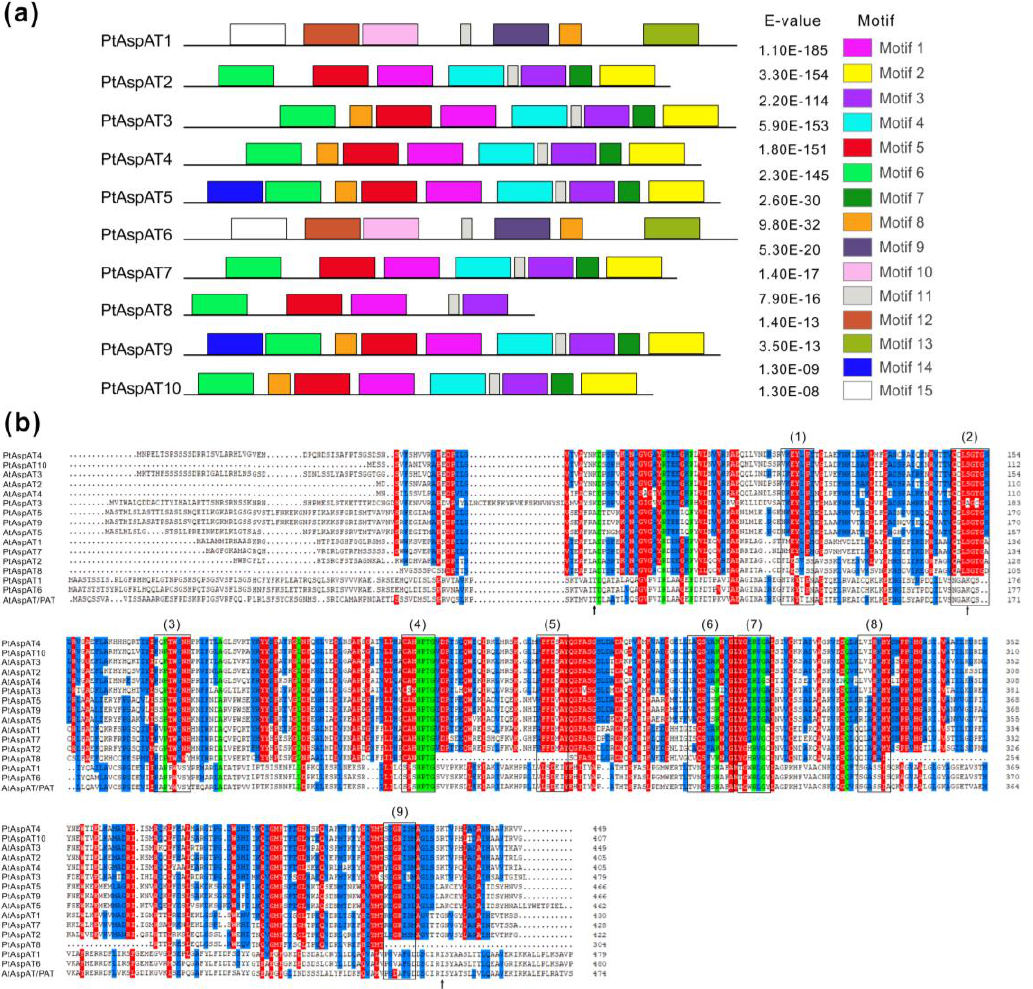
Figure 4. Conserved motifs and amino acid residues of AspATs. ( a ) MEME analysis showing distributions of 15 conserved motifs in 10 PtAspATs that were demonstrated with a colorful box. Detailed information is provided in Table S2. ( b ) Conserved patterns of AspATs in Arabidopsis (AtAspAT1 to AtAspAT5, and the bifunctional enzyme AtAspAT / PAT) and Populus . Nine fragments involved in binding with PLP (pyridoxal 5’-phosphate) or dicarboxylic substrate are highlighted in black boxes. The three residues reported in recognition of prephenate and Asp substrates of the I β subfamily are marked with black arrows.